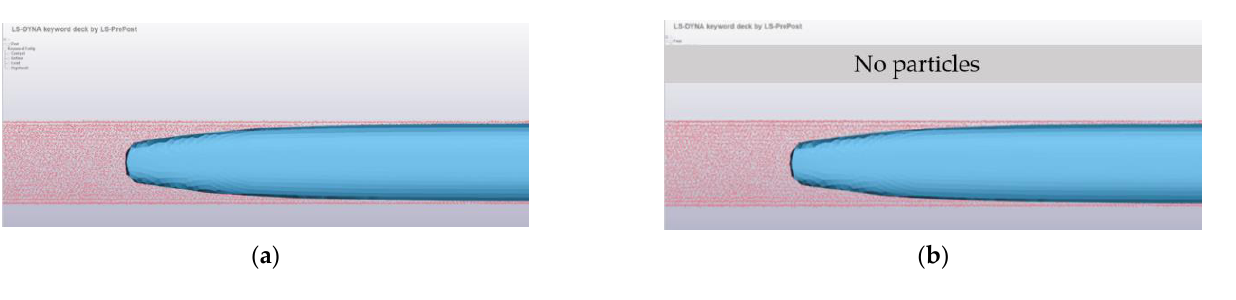
Figure 9. These are the two working conditions of Scenario 1: ( a ) conditions in the fourth-level